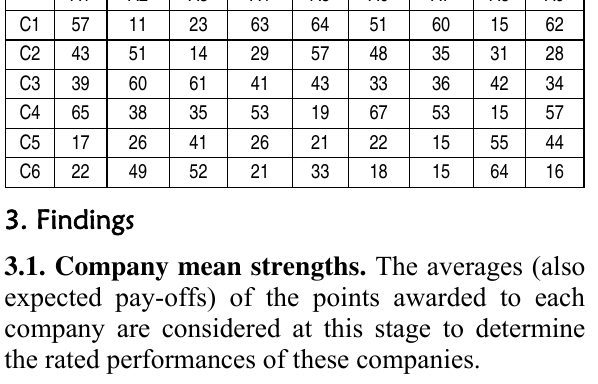
Table 3. ANOVA: 1-factor without